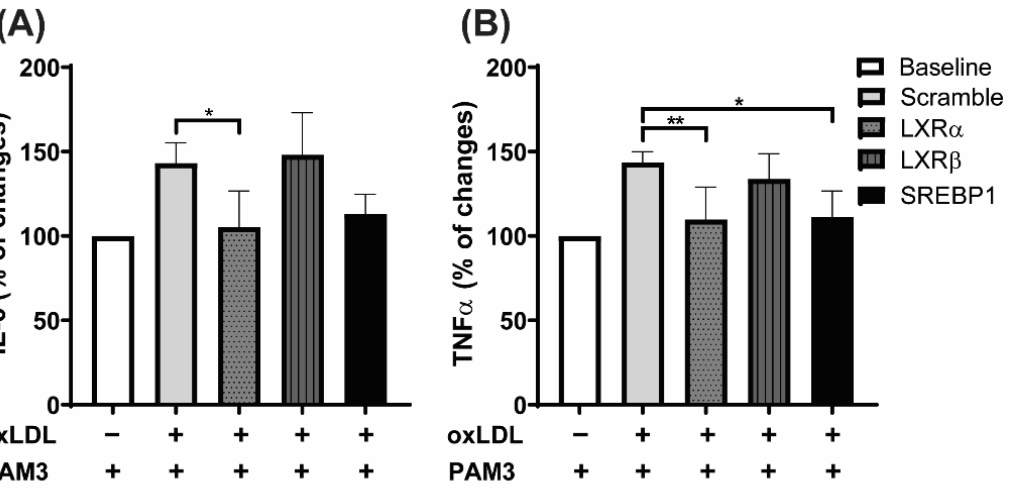
Figure 5. LXR α and SREBP1 play an important role in regulating oxLDL-induced trained immunity. Differentiated THP1 cells were transfected with siRNA against LXR α , LXR β , and SREBP1 or scram- bled siRNA and treated with 20 µ g/mL oxLDL or vehicle for 24 h. Cells were rested for 5 days and restimulated with 10 µ g/mL Pam3cys for 24 h. IL-6 and TNF α were measured in the supernatant ( A , B ). Graphs represent mean values ± SD of three different experiments. * p < 0.05 and ** p < 0.01.